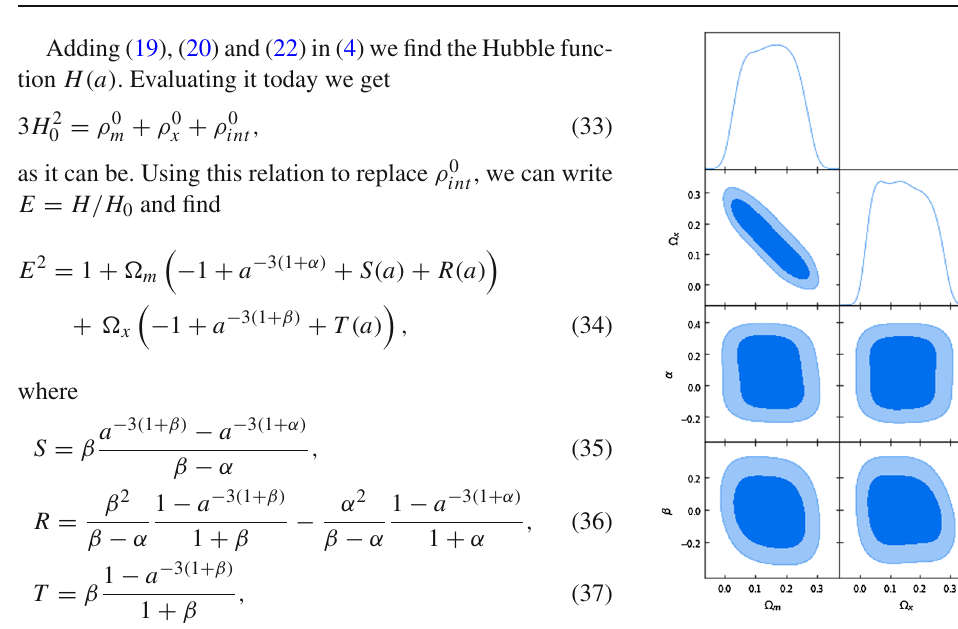
Fig. 3 Here we show the result of the statistical analysis using the Pantheon sample of type Ia supernovae